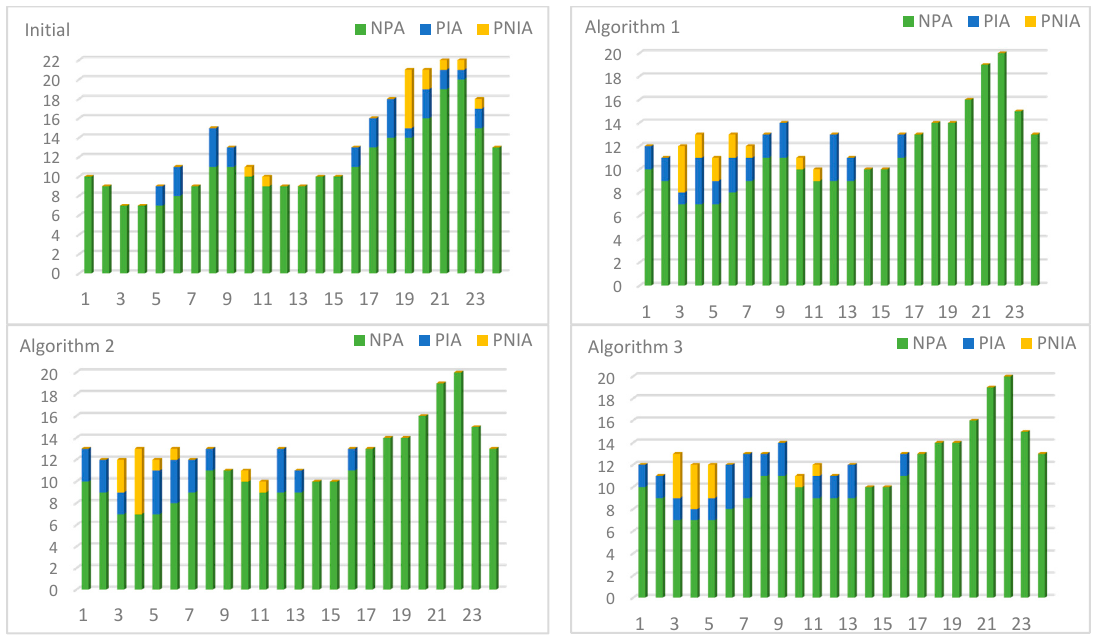
Figure 10. Consumption of different type of appliances for initial schedule and shifting algorithms.